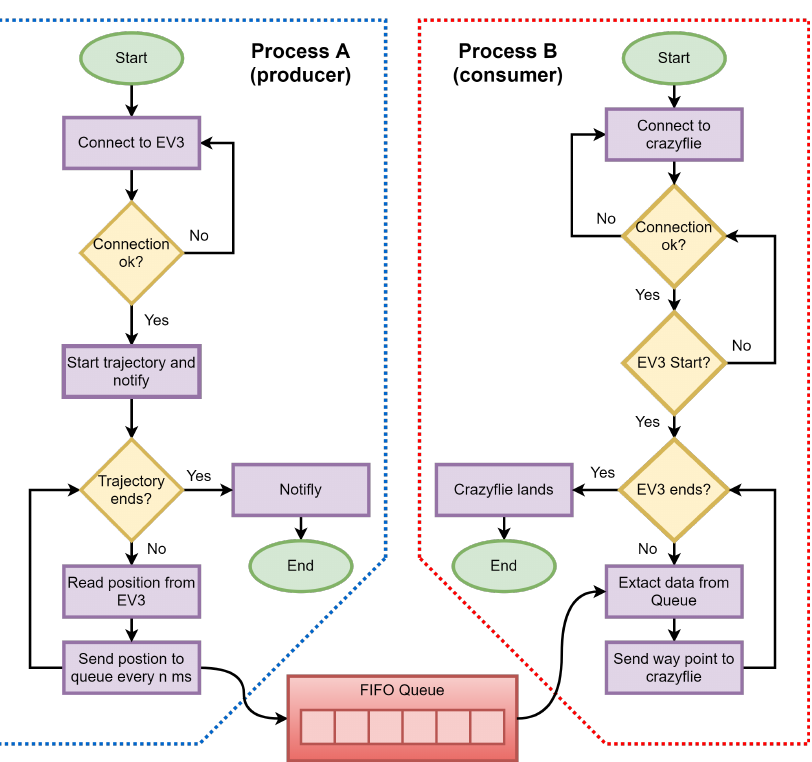
Figure 7. Flowchart of the process A (producer) implemented for the mobile robot EV3 and of the process B (consumer) implemented for the Crazyflie quadcopter.